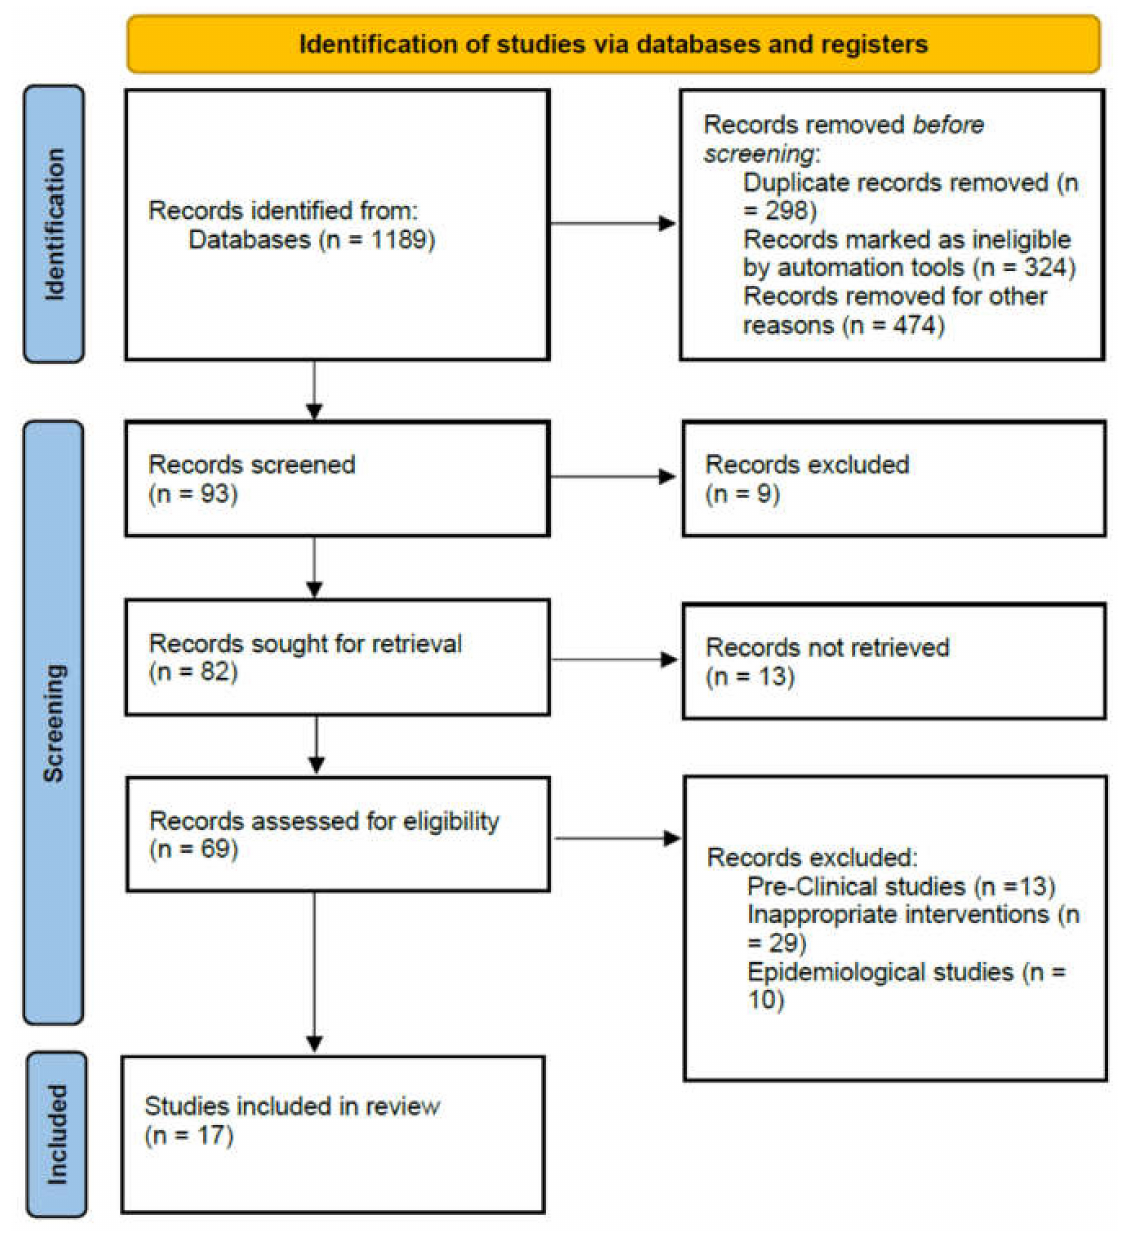
Figure 1. PRISMA flow diagram reporting the procedure of selection of